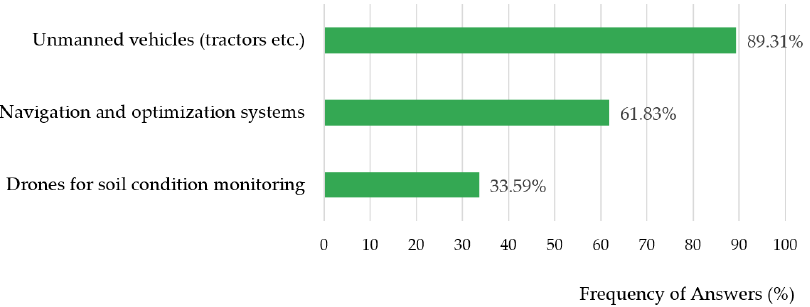
Figure 2. Use of machines in crop production.